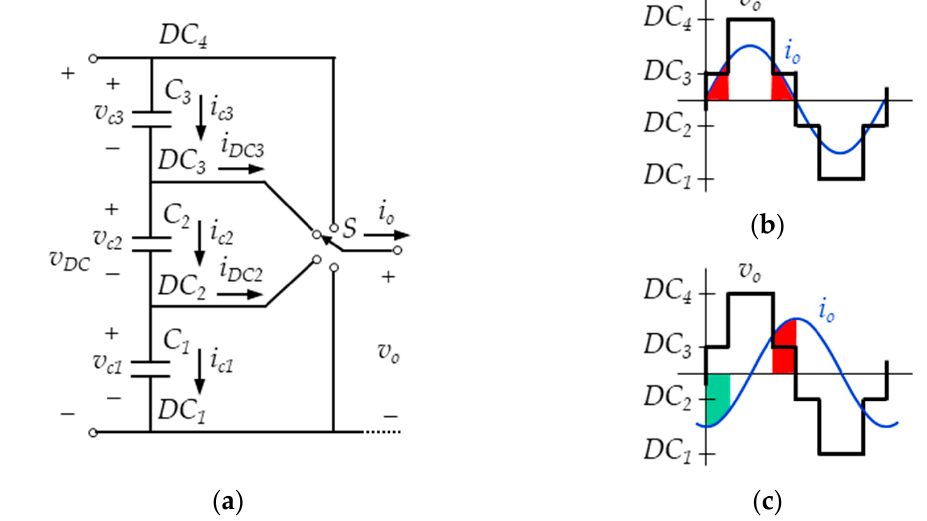
Figure 9. Current through the neutral point DC 3 ( i DC 3 ) . In red, the current flows out of the neutral point DC 3 (positive i DC 3 ); in green, the current flows into the neutral point DC 3 (negative i DC 3 ): ( a ) functional model of a 4-level NPC leg; ( b ) case with pure active output current (power factor = 1); ( c ) case with pure reactive output current (power factor = 0).